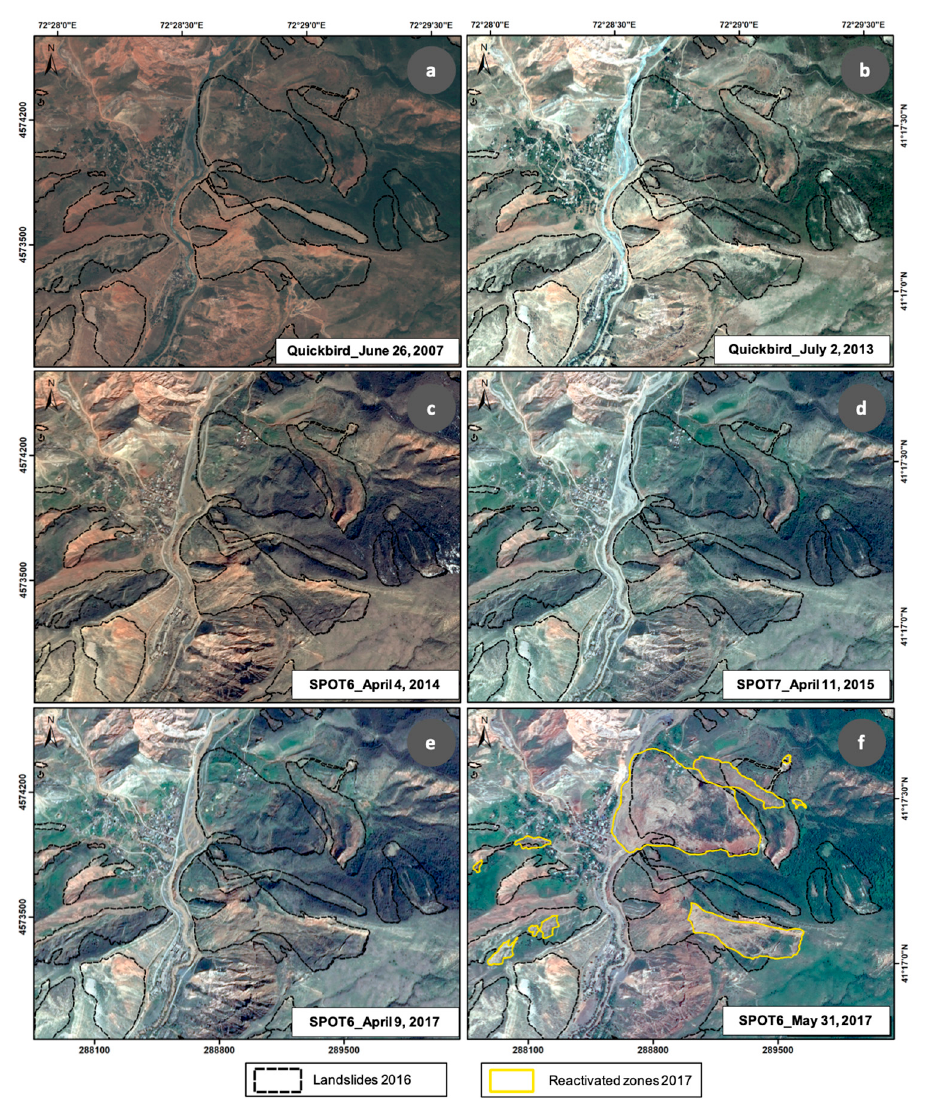
Figure 11. Multitemporal optical analysis of Maily-Say landslides since 2007. This time series was carried out using the latest inventory of landslides to date based on the mapping of a Quickbird image from 26 June 2007 [37]. The landslide boundaries mapped in 2016 are represented by dashed black lines while the reactivated areas are indicated in yellow: ( a ) Quickbird of 26 June 2007; ( b ) Quickbird of 2 July 2013; ( c ) SPOT 6 of 1 April 2014; ( d ) SPOT 7 of 11 April 2015; ( e ) SPOT 6 of 9 April 2017; and ( f ) SPOT 6 of 31 May